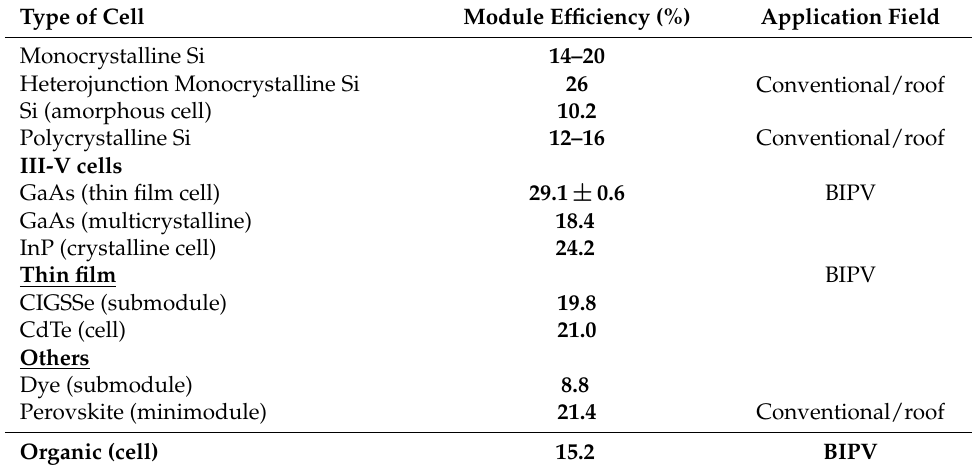
Table 1. Types and efficiencies of PV cells, data used from [20].